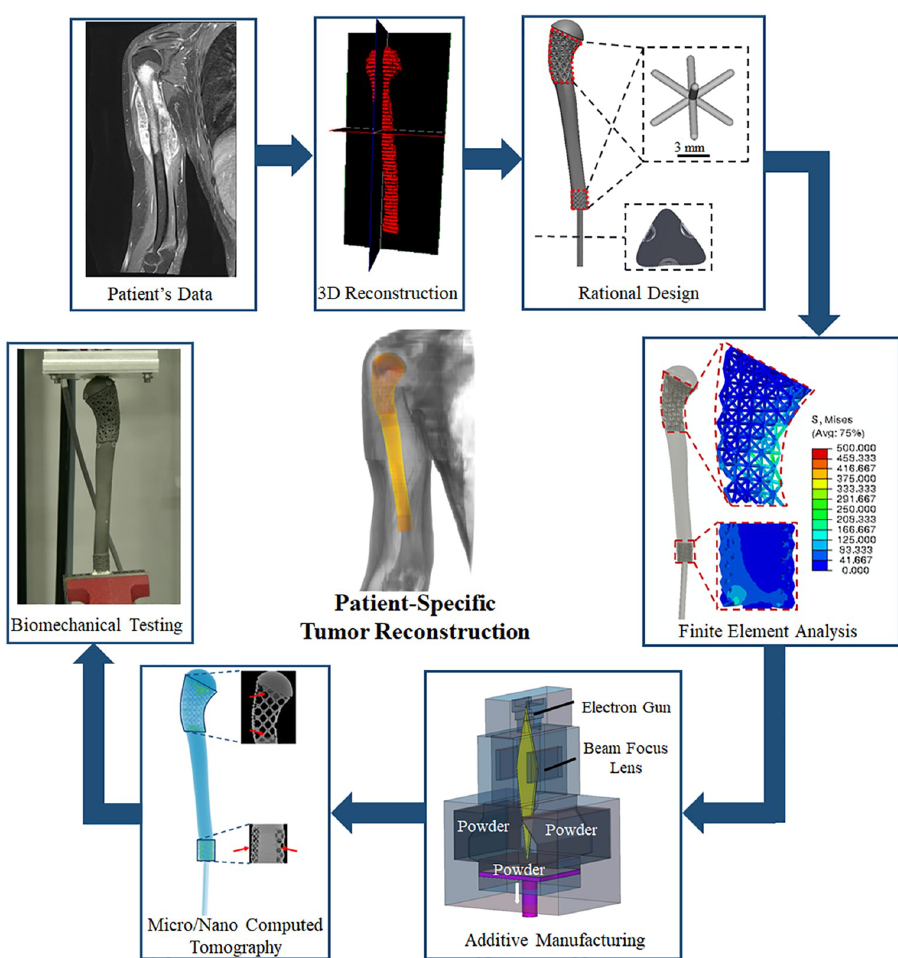
Fig 1. Design workflow for patient-specific AM prosthesis for reconstruction of large bone defects after tumor resection including computed tomography (CT) of metal AM prosthesis.